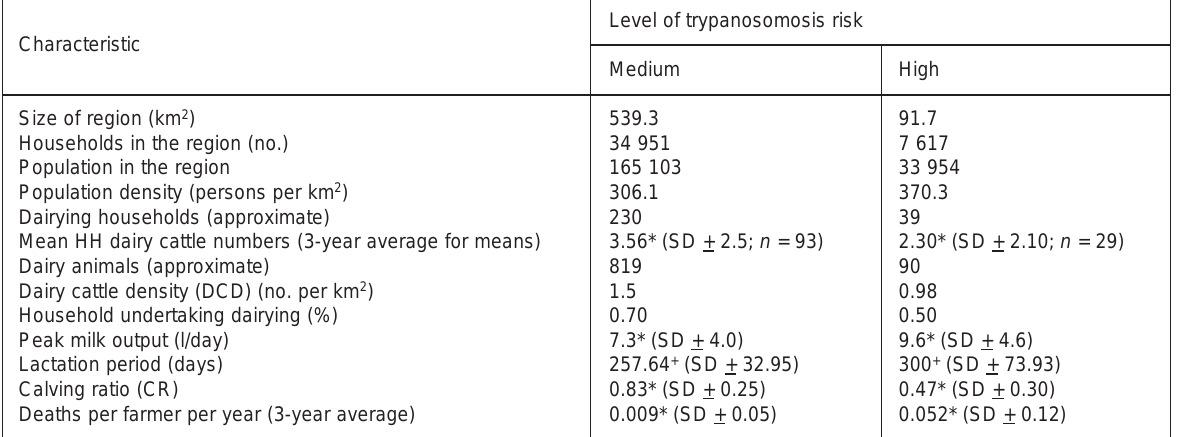
Values with the same superscript are significantly different between groups ( P = 0.05) TABLE 3 Relation between dairy cattle density indicators and trypanosomosis risk